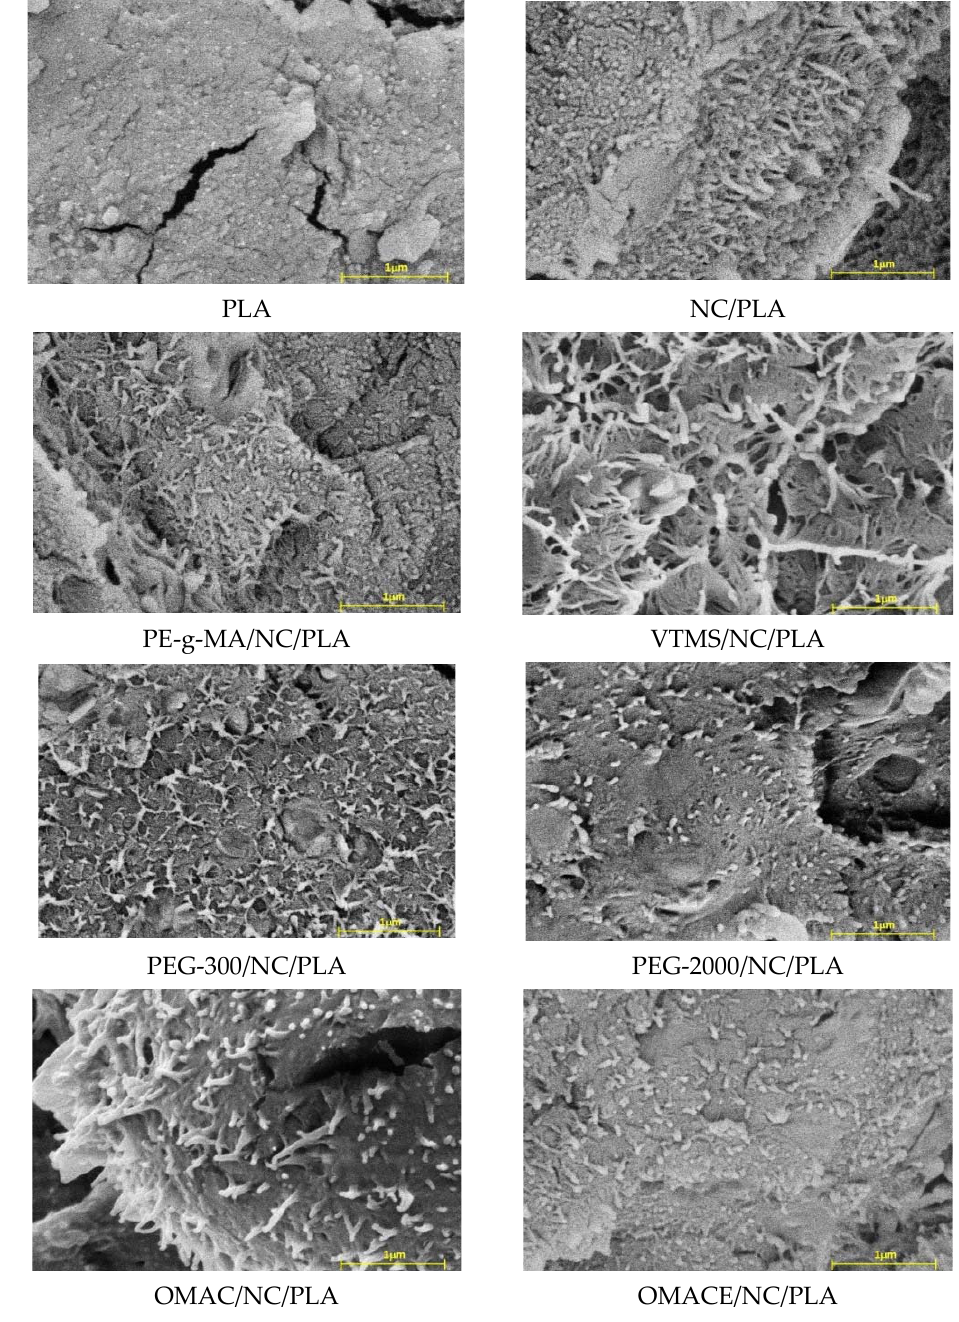
Figure 4. The SEM micrographs of samples.